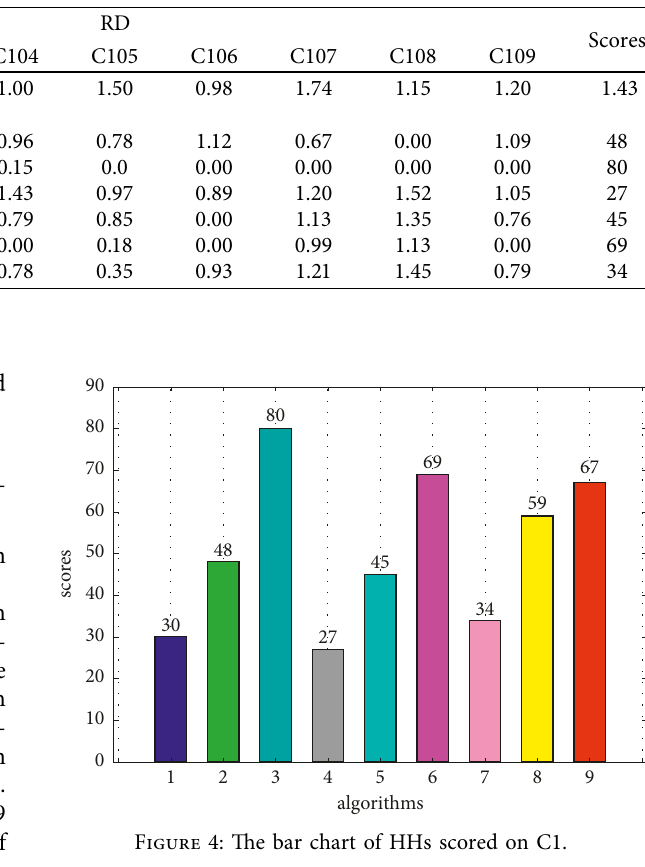
Table 8: Results of C101–C109 obtained by 9 HHs.